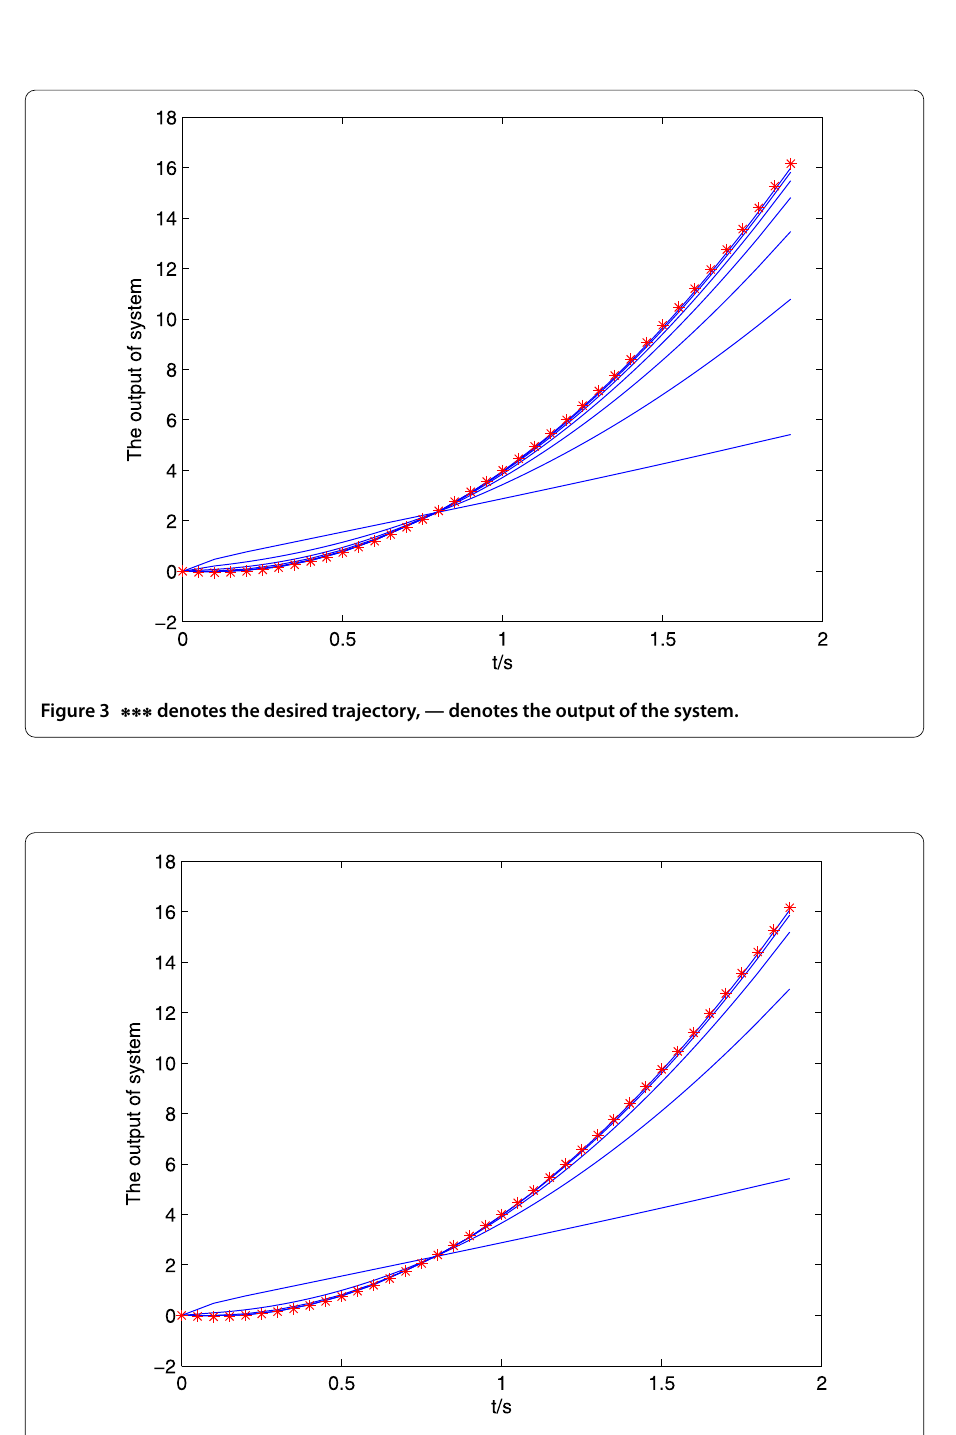
Figure 4 ∗∗∗ denotes the desired trajectory, — denotes the output of the